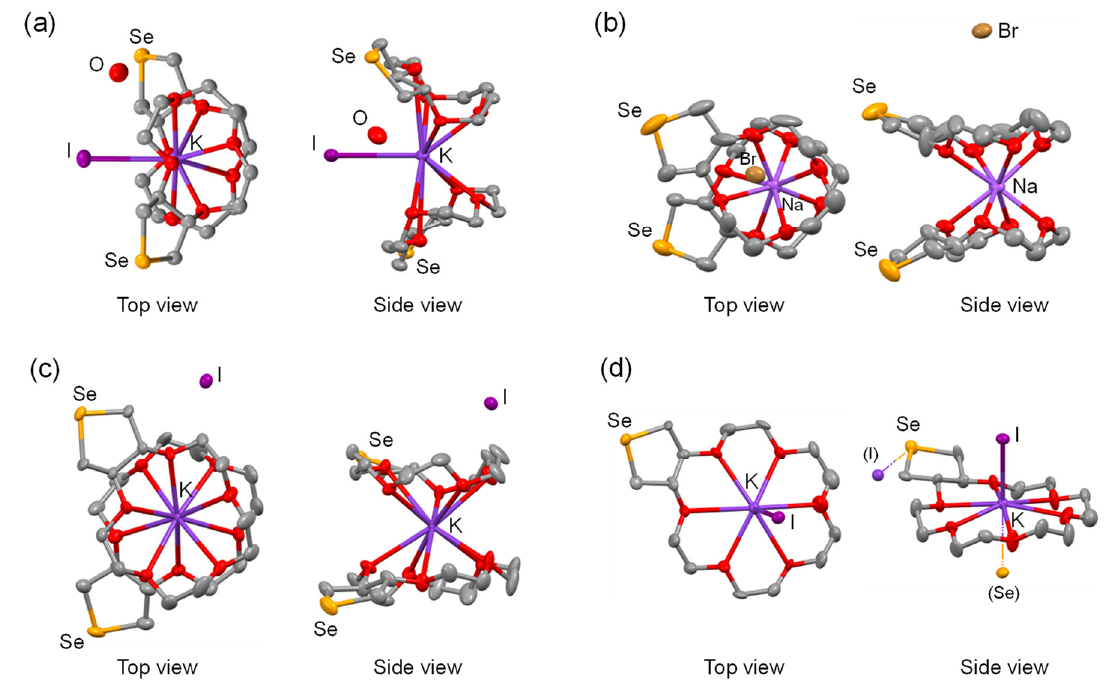
Figure 2. X-ray structures for the alkali metal complexes of DHS-crown- n . ( a ) DHS-crown-4 ( 1 ) · 0.5KI · H 2 O ( 5 ). ( b ) DHS-crown-4 ( 1 ) · 0.5NaBr · 2H 2 O ( 6 ) with water molecules omitted for clarity. ( c ) DHS-crown-5 ( 2 )·0.5KI ( 7 ). ( d ) DHS-crown-6 ( 3 )·KI ( 8 ). Ellipsoids are drawn with 50% probabilities.